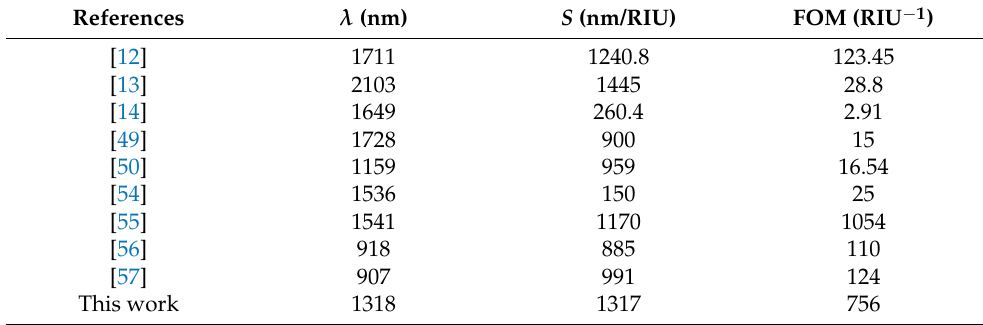
Figure 7. ( a ) Normal-incidence absorption spectra with the refractive index ( n ) of surrounding medium increased from 1.0 to 1.1 in steps of 0.02. ( b ) The position of absorption peak for different n . Table 1. Performance of sensors based on perfect absorption in the near-infrared region.